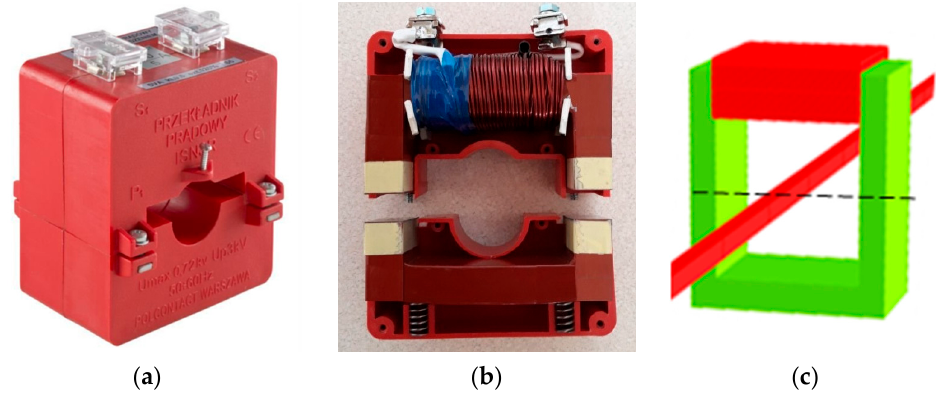
Figure 10. Comparison of the characteristics of the current error ( a ) and phase displacement ( b ) for 600 A/5 A of current transformers with different cores and secondary windings arrangements at a power load of S n = 5 VA. cos φ = 0.8 (I pn = 600 A).